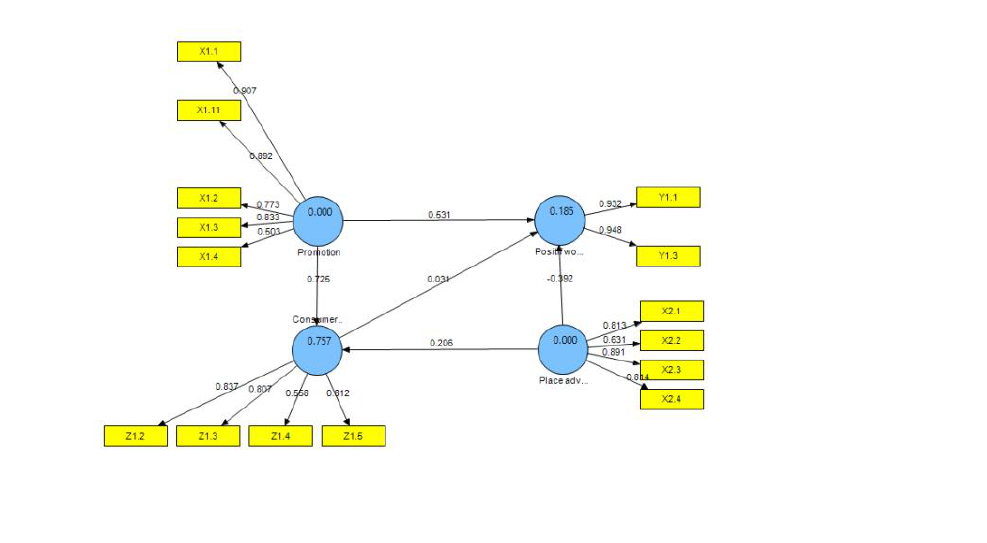
Figure 2: Measurement model; Source: Results of data analysis for